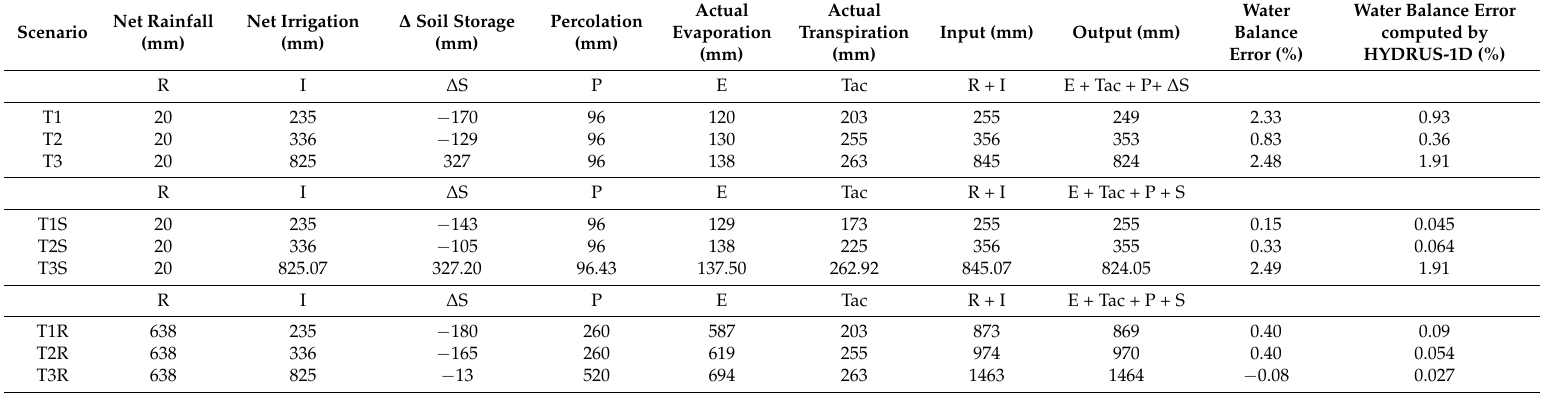
Table 5. Calculated water balance for different treatments for the crop and rainfall